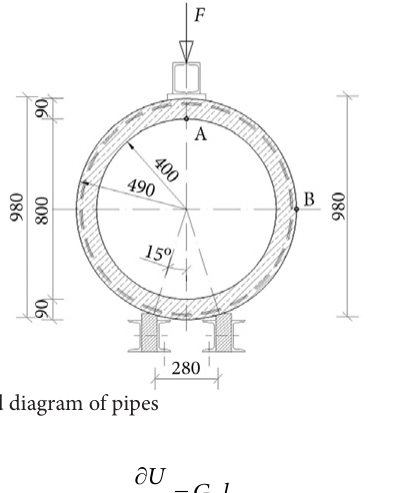
Fig. 3. Load diagram of